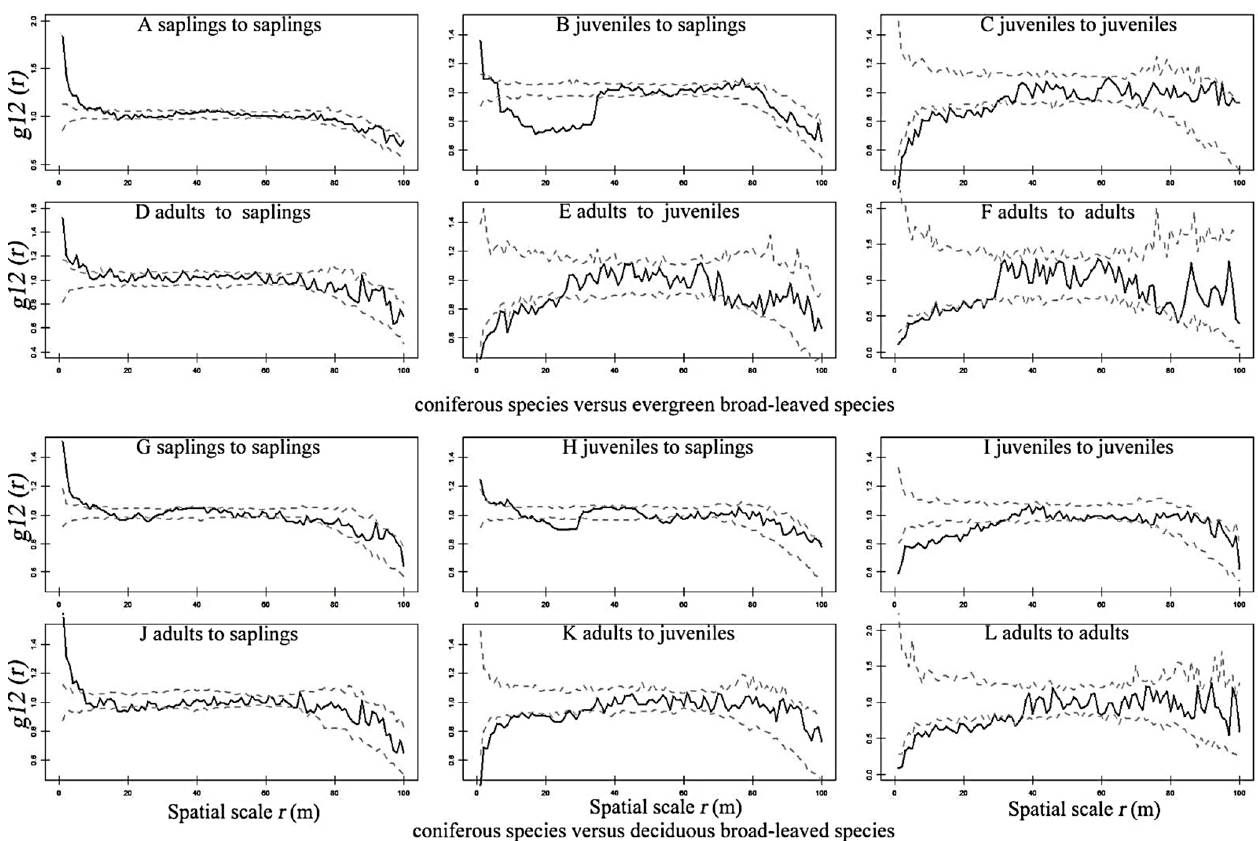
Figure 4. Spatial associations of coniferous species versus broad-leaved species among different DBH classes. Figures represent the analysis of point patterns of three size classes (saplings as 1 cm ≤ DBH < 5 cm; saplings as 5 cm ≤ DBH < 15 cm; adults as DBH ≥ 15 cm). Dotted lines represent the 99% confidence interval and the black lines represent the g12(r) function. Observed values below the lower limits represent a negative association, values above the upper limits mean positive association, and values within the intervals mean there is no association. ( A , G ) saplings to samplings; ( B , H ) juveniles to saplings; ( C , I ) juveniles to juveniles; ( D,J ): adults to saplings; ( E , K ): adults to juveniles; ( F , L ) adults to adults.